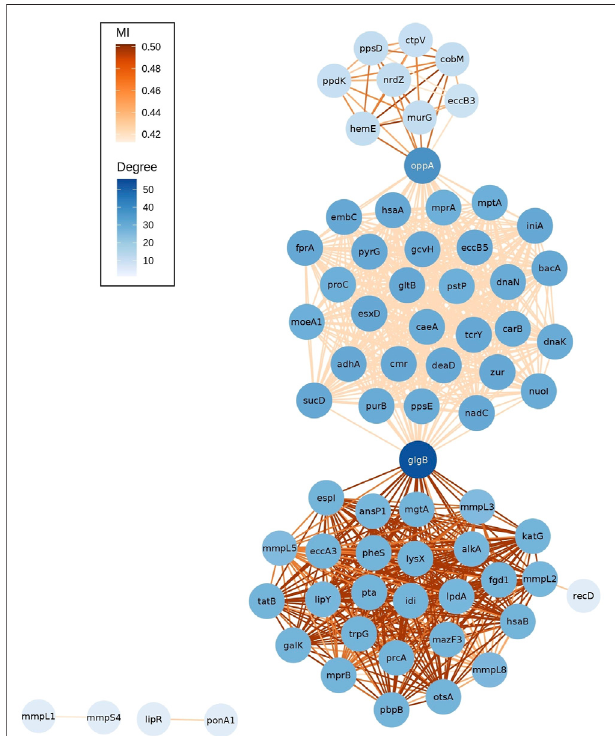
FIGURE 3 | Network of outlier epistatic interactions. The gradient color of nodes depicts the node degree. The gradient color of edges depicts values of